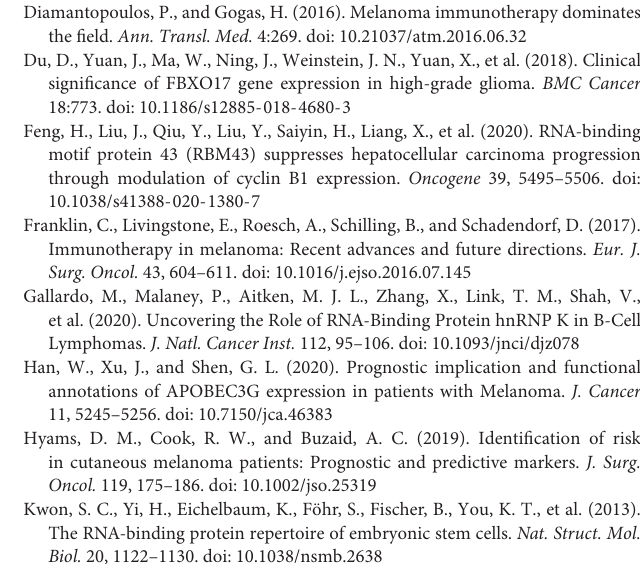
Supplementary Figure 1 | KM analysis of the OS between the high- and low-risk groups in 5 types of cancer using the TCGA pan-cancer data. Supplementary Figure 2 | KM analysis of the OS between the high- and low-risk groups in other 27 types of cancer using the TCGA pan-cancer